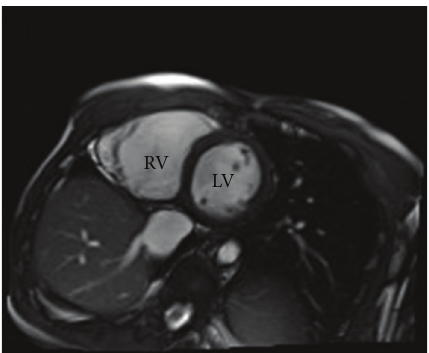
Figure 3: Cardiac magnetic resonance imaging showing right ventricular (RV) enlargement as compared to the left ventricular (LV) size with calculated right ventricular ejection fraction of